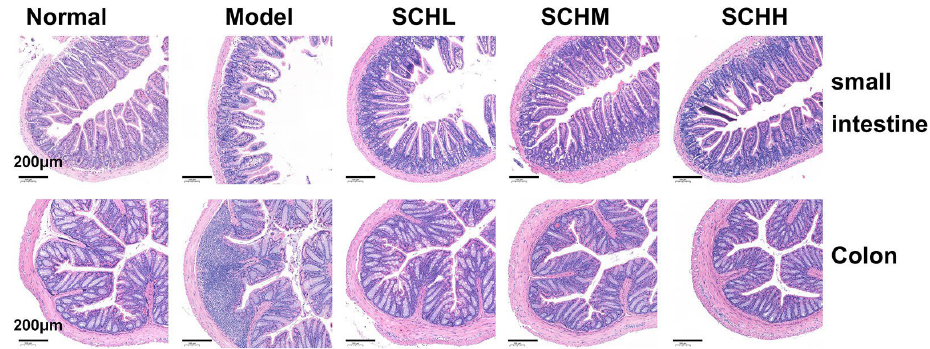
Figure 4. Effect of SCH on the morphology of the small intestine and colon in immunosuppressed mice ( n ≥ 3 ).